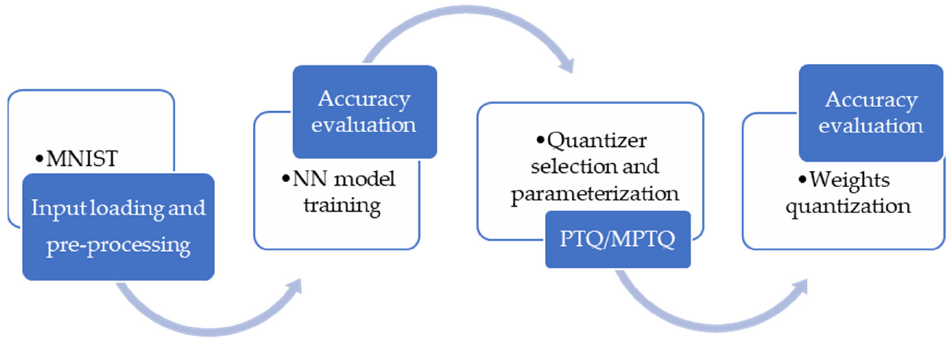
Figure 4. Post-training procedure by applying two novel two-bit quantizers. Training and accuracy evaluation of our NN model is implemented in